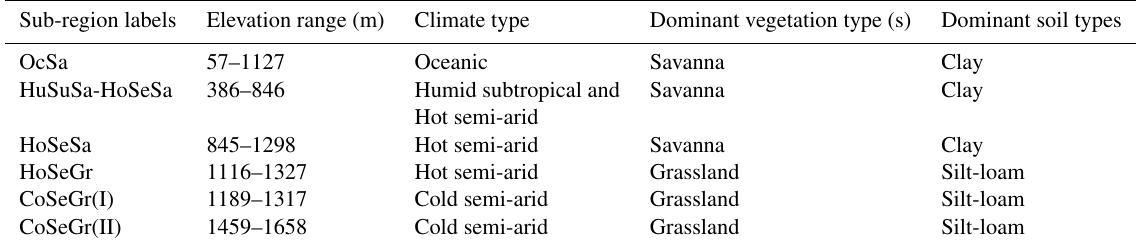
Table 2. A detailed description of the selected sub-regions indicating elevation (https://www.ngdc.noaa.gov/mgg/fliers/06mgg01.html, last access: 14 December 2019), climate (http://koeppen-geiger.vu-wien.ac.at/present.htm, last access: 14 December 2019), and vegetation and soil types (https://soilgrids.org, last access: 14 December